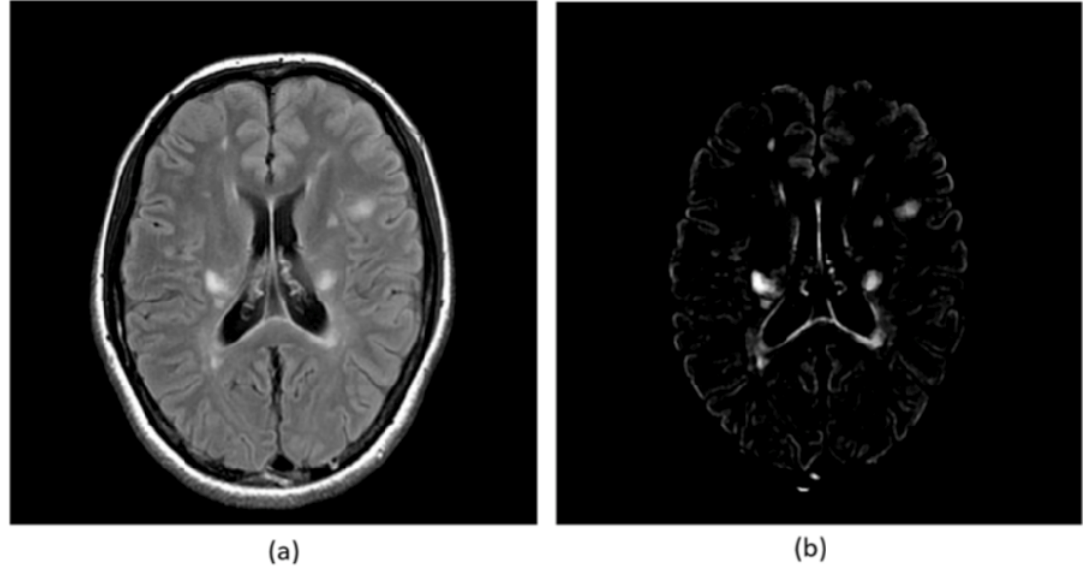
Figure 5. Illustrations of (a) an original FLAIR image, and (b) its corresponding subtraction image between the FLAIR image and a background image approximated by the first order polynomial in a brain region